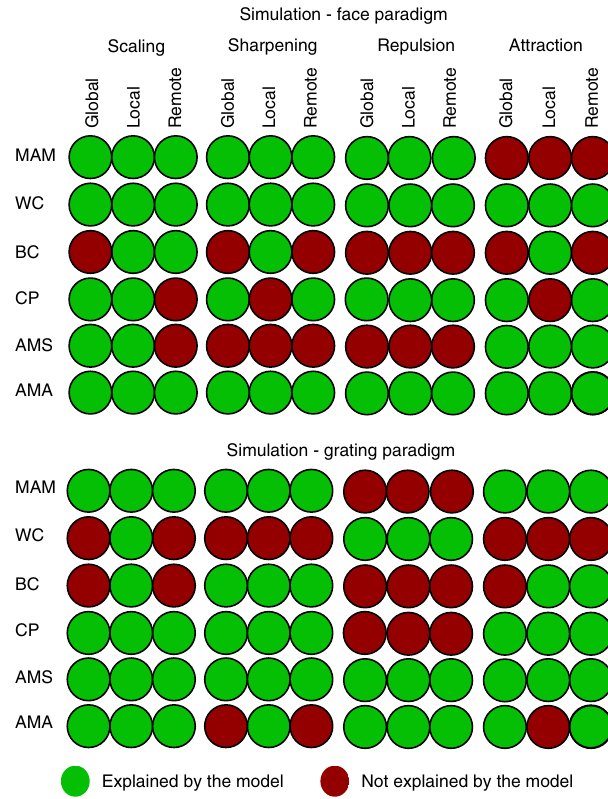
Fig. 5 The maximum number of data properties explained by each model when parameters are constrained to be equal across all data properties (but can differ across experiments). Note that, for some models that can explain only 4 or 5 data properties with the same parameter values, there may be different subsets of the same number of data properties that can be explained (i.e., this fi gure only shows one such subset). Mechanisms: scaling – adaptation reduces response amplitude, sharpening – adaptation tightens tuning-curves, repulsion – the peak of tuning-curves moves away from the adapting stimulus, attraction – the peak moves towards the adapting stimulus. Domains: global – all tuning-curves in a voxel are affected, local – tuning-curves close to the adapting stimulus are affected most, remote – tuning-curves close to the adapting stimulus are affected least. Data features: Mean Amplitude Modulation (MAM), Within-class Correlation (WC), Between-class Correlation (BC), Classi fi cation Performance (CP), Amplitude Modulation by Selectivity (AMS) and Amplitude Modulation by Amplitude